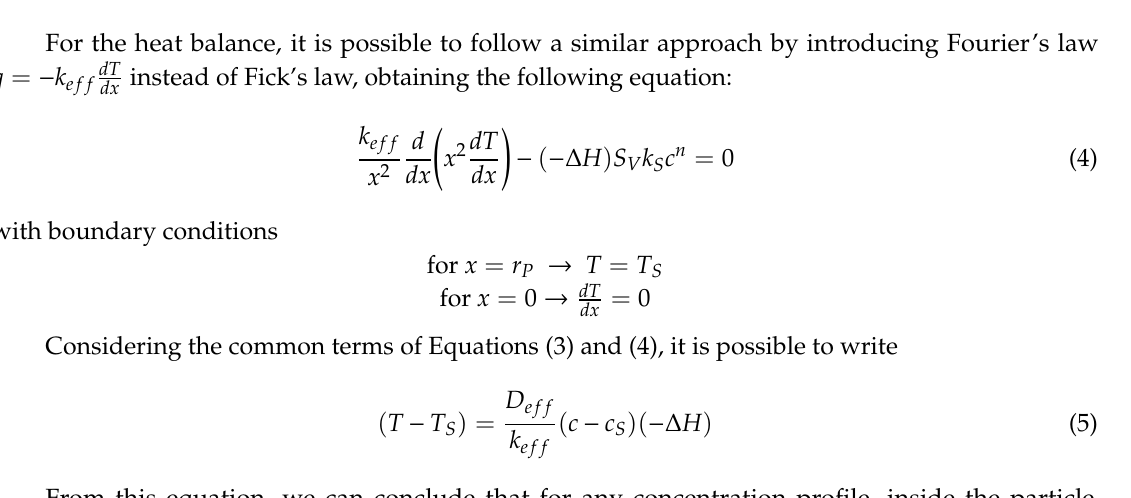
Figure 4. Reference scheme for mass and heat balance related to a catalyst particle.